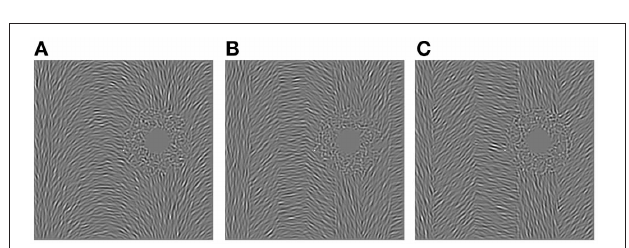
FIGURE 5 | Manipulating the smoothness of an orientation gradient via quantization of orientation within discrete spatial bands. Each of the textures shown contain an constant linear change in orientation as a function of horizontal position, but have been quantized within bands measuring (A) 4 ◦ (B) 8 ◦ , or (C) 12 ◦ . Within each band all texture elements have a constant orientation, determined by space-averaging the underlying orientation